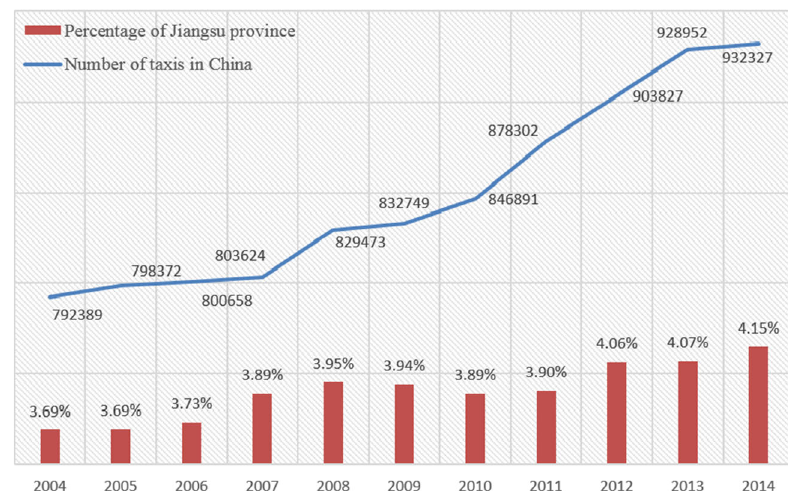
Fig. 1 Number of taxis in China and Jiangsu province (2004 –